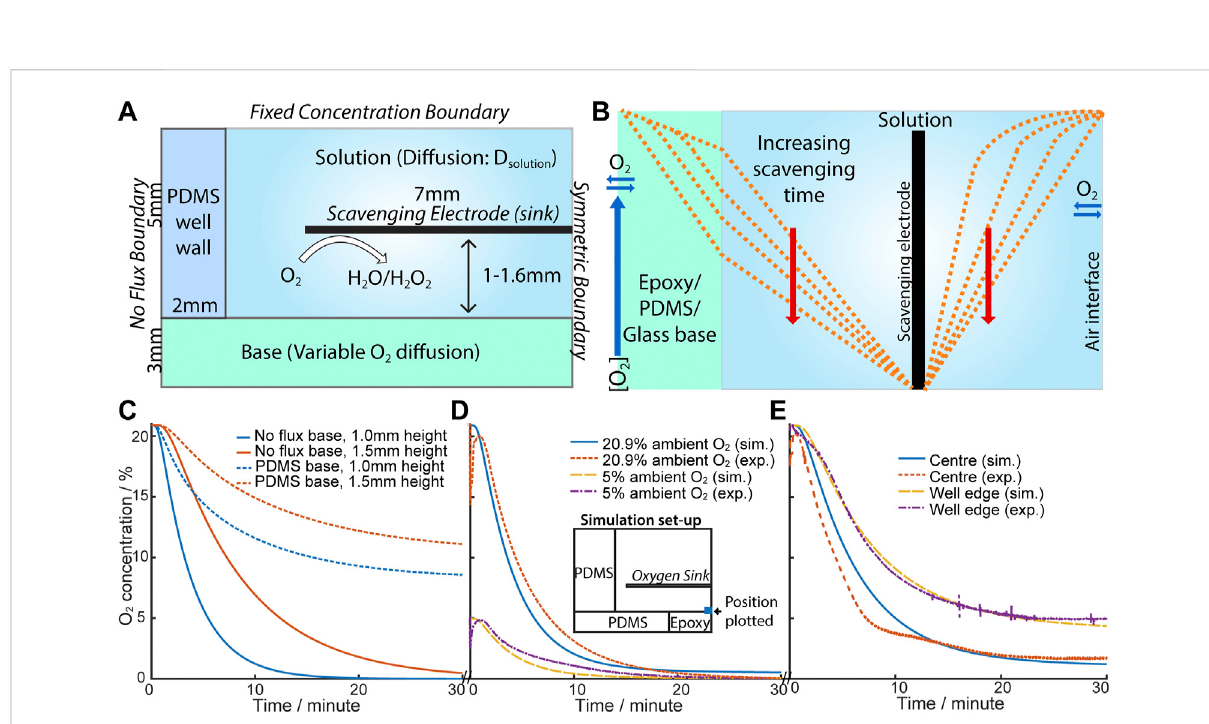
FIGURE 3 (A) Schematic diagram of the simulation of eLOS. (B) Schematic illustration of the oxygen concentration change when the oxygen scavenger is switched on (oxygen sink). (C) Plot of simulation results with no fl ux (epoxy/glass) base (solid line) and fl ux (PDMS) base (dotted line); 1.0 mm (blue), 1.5 mm (red). (D) Comparison of exp. and sim. [O 2 ] in ambient [O 2 ] at 20.9% and 5%. Inset: schematic of simulation set-up used. Scavenger is at 1.1 mm above base. (E) Comparison of exp. and sim. [O 2 ] across the base. Scavenger is at 1.5 mm above